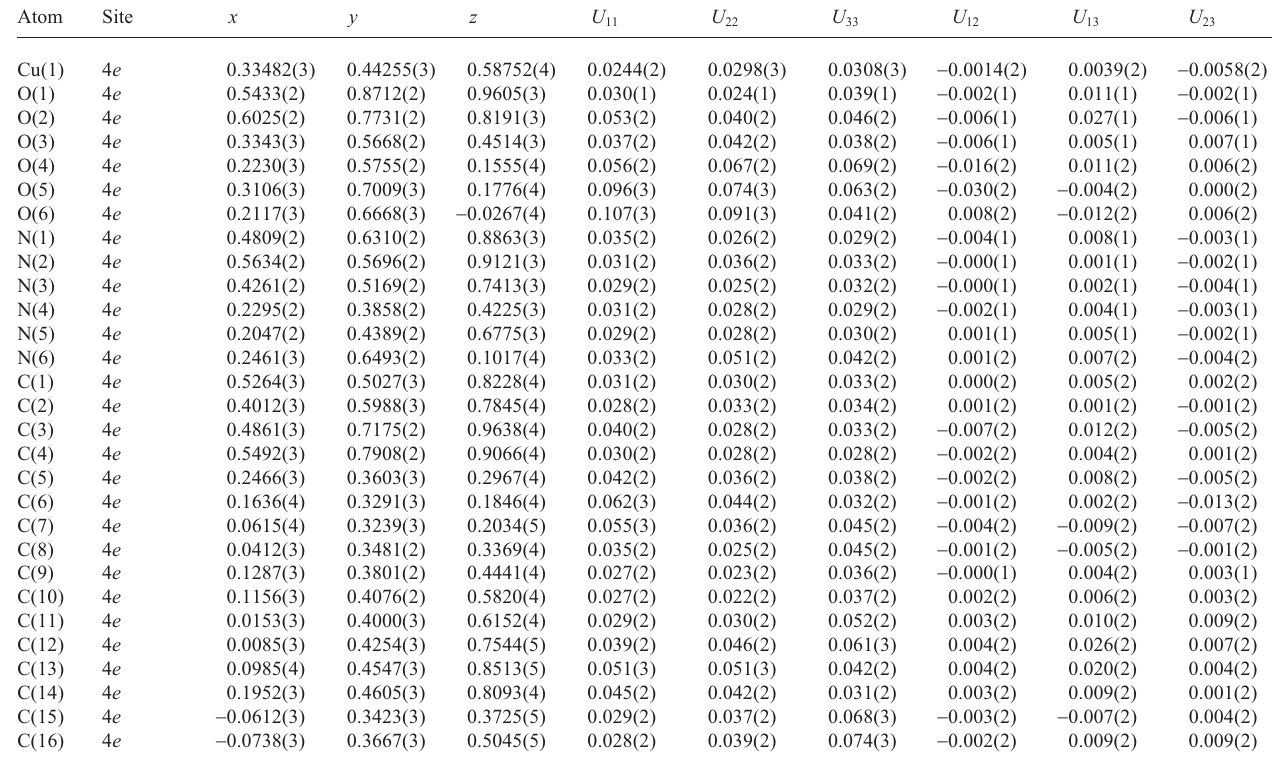
Table 3. Atomic coordinates and displacement parameters (in Å 2 )